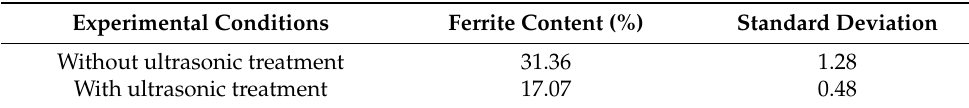
Table 2. Ferrite content in the